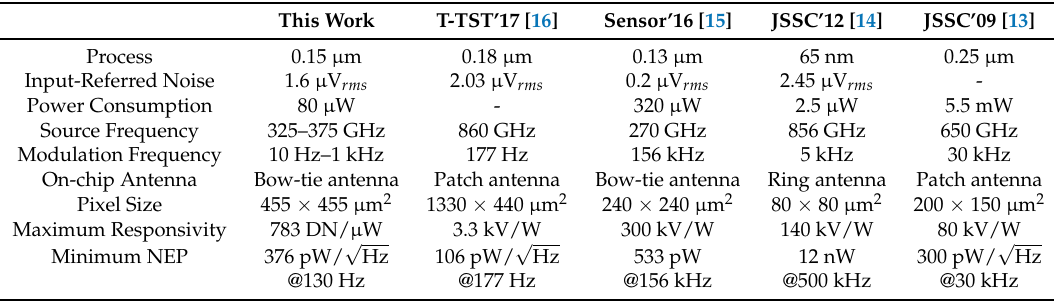
Table 1. Performance comparison with the recently reported state of the